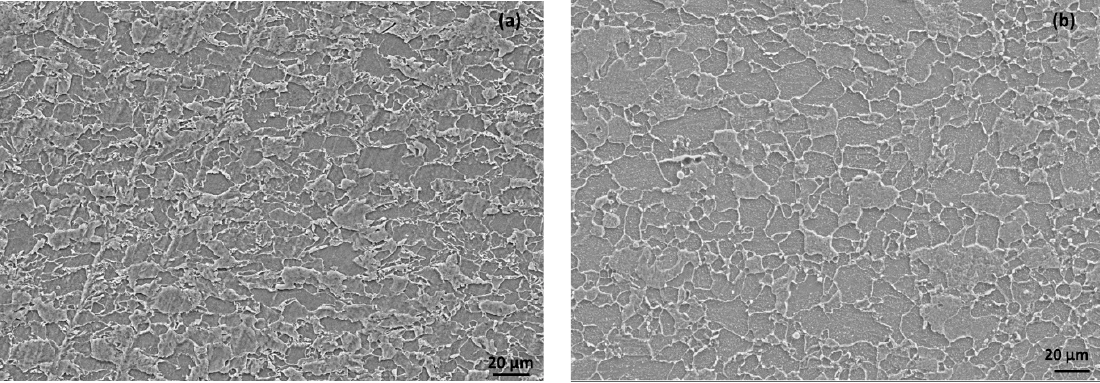
Figure 1. Micro-structure of ( a ) disc and ( b ) pin.